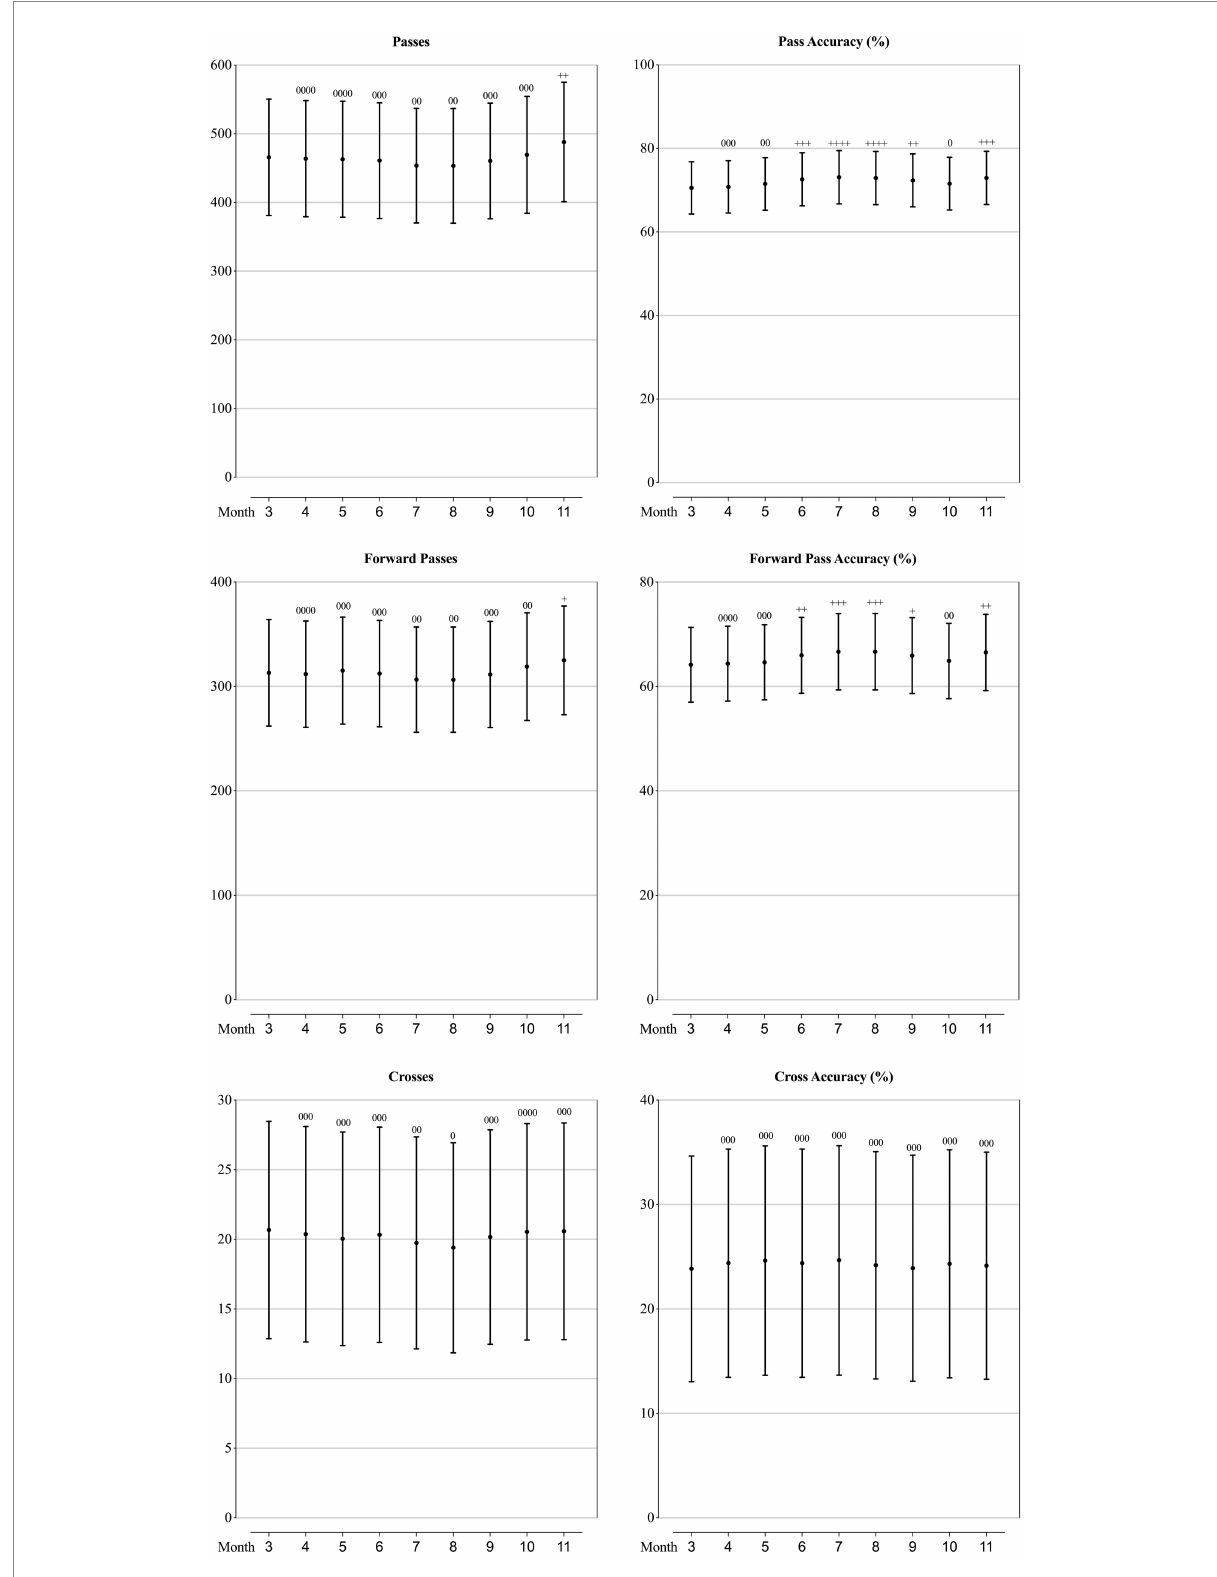
FIGURE 4 Values of passing-related parameters in each month of a season for the teams competing in the CSL in 2012-2019 estimated from the generalised mixed linear modelling. Filled dots are the means. Error bars are the standard deviations. Symbols “0” and “+” stands for trivial and positive change from the value of March (month “3”). Number of symbols indicate the likelihood for the magnitude of the true effect as follows: 1-possible; 2-likely; 3-very likely; 4-most